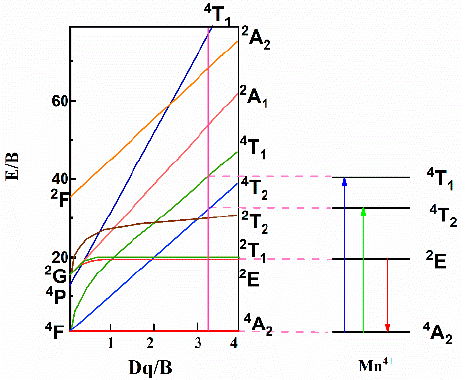
Based on Equations (1)–(4), the crystal field parameters of Dq , B , C were determined to be 2105, 638 and 3660 cm − 1 , respectively.